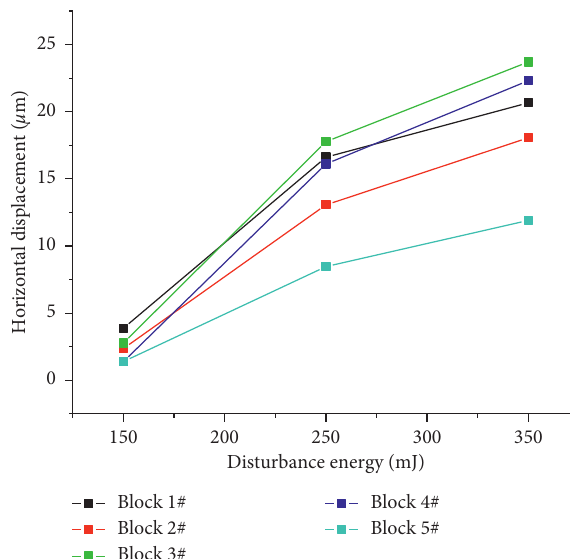
Figure 9: Maximum horizontal displacements of rock